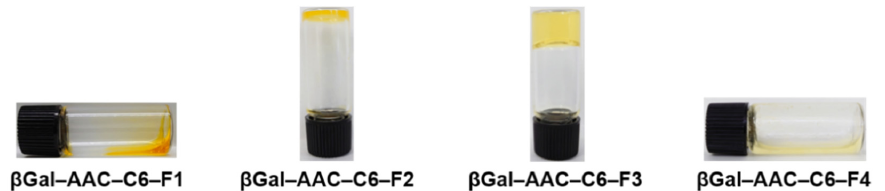
Figure 3. Photographs of compounds at room temperature (around 23 °C); [ β Gal–AAC–C6–F1] = 2.4 wt%, [ β Gal–AAC–C6–F2] = 2.4 wt% (CGC), [ β Gal–AAC–C6–F3] = 0.19 wt% (CGC), and [ β Gal–AAC–C6–F4] = 0.35 wt% in 200 mM HEPES–NaOH buffer (pH 8.0). Table 1. Gelation ability, critical gelation concentration (CGC), the gel-to-sol phase transition tem- perature ( T gel ) of hydrogels at CGC, and absorption maxima ( λ max ) at room temperature (around 23 °C) of lipopeptide-type bola-amphiphiles. Conditions: 200 mM HEPES–NaOH buffer (pH 8.0). Compound Gelation Ability